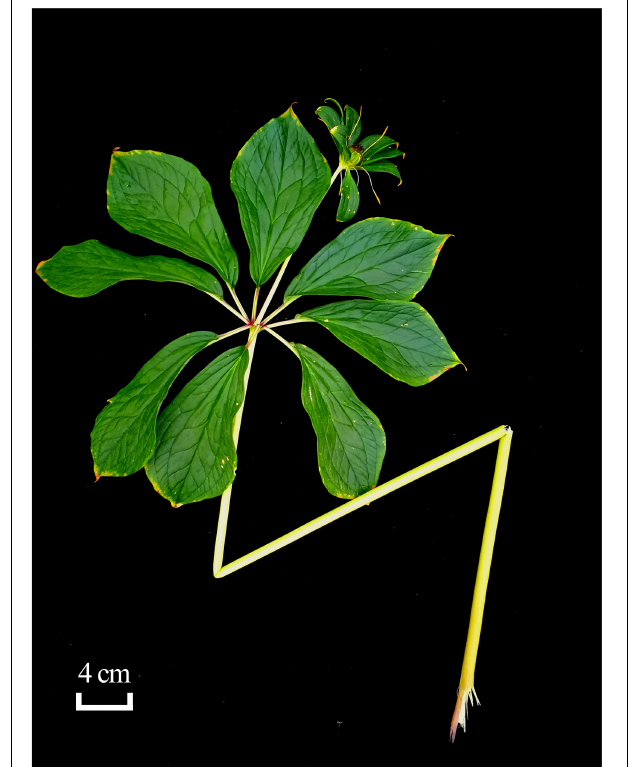
FIGURE 7 | Holotype of Paris liiana sp.